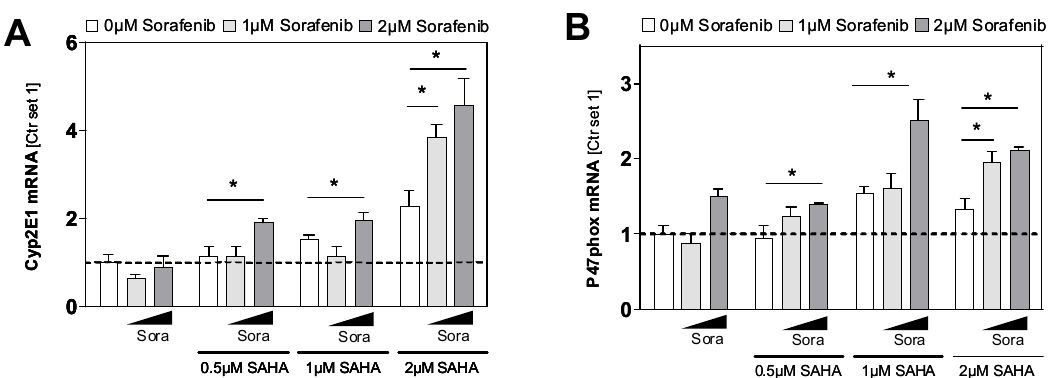
Figure 8. Cyp2E1 and p47phox expression 24 h after combined sorafenib and SAHA treatment. ( A ) Cyp2E1 and ( B ) p47phox mRNA expression in HCC cells treated with sorafenib (Sora) and/or SAHA. Control cells (Ctr.) treated with solvent (DMSO) only were set at a value of 1. (*: p < 0.05).